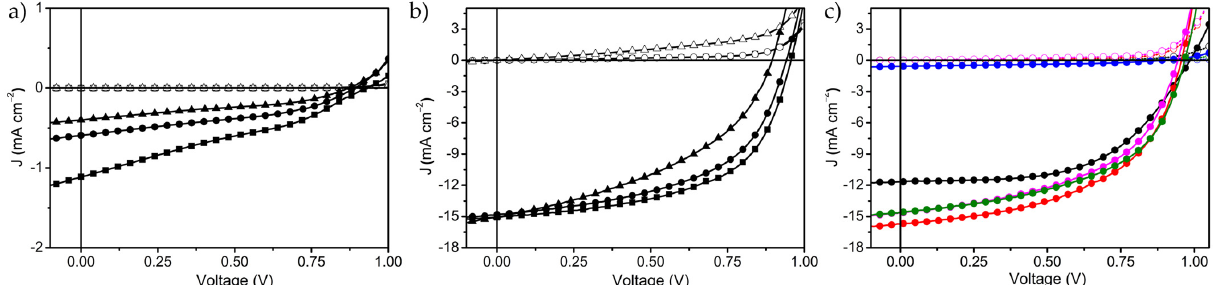
Figure 4. Dark (open symbol-lines) and light (filled symbol-lines) I–V curves of planar perovskite solar cells prepared on Au-network electrodes with the pitch size of 97 μ m (square-line), 196 μ m (circle-line) and 293 μ m (triangle-line) containing ( a ) LT-TiO 2 and ( b ) AZO filler layers; ( c ) comparison of dark (open symbol-lines) and light (filled symbol-lines) current–voltage (I–V) curves of perovskite solar cells prepared on reference ITO/LT-TiO 2 (black-circle-line), ITO/AZO (red-circle-line) and hybrid Au-network/LT-TiO 2 (blue-circle-line), Au-network/AZO (magenta-circle-line) and Cu-network/AZO (green-circle-line) electrodes with 196 μ m pitch size. Table 1. Photovoltaic parameters of the planar perovskite solar cells prepared on Au-network with increasing charge carrier extraction length, and LT-TiO 2 and AZO conducting filler layers. Electrode and Filler Layer Electrode and Pitch Size ITO/LT-TiO 2 Filler Layer ITO/LT-TiO 2 (Reference) Au